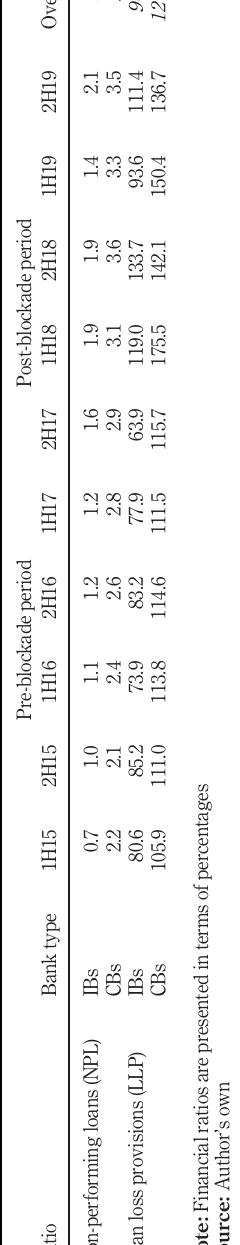
Table 6. Period-and-group- wise comparison of bank asset quality